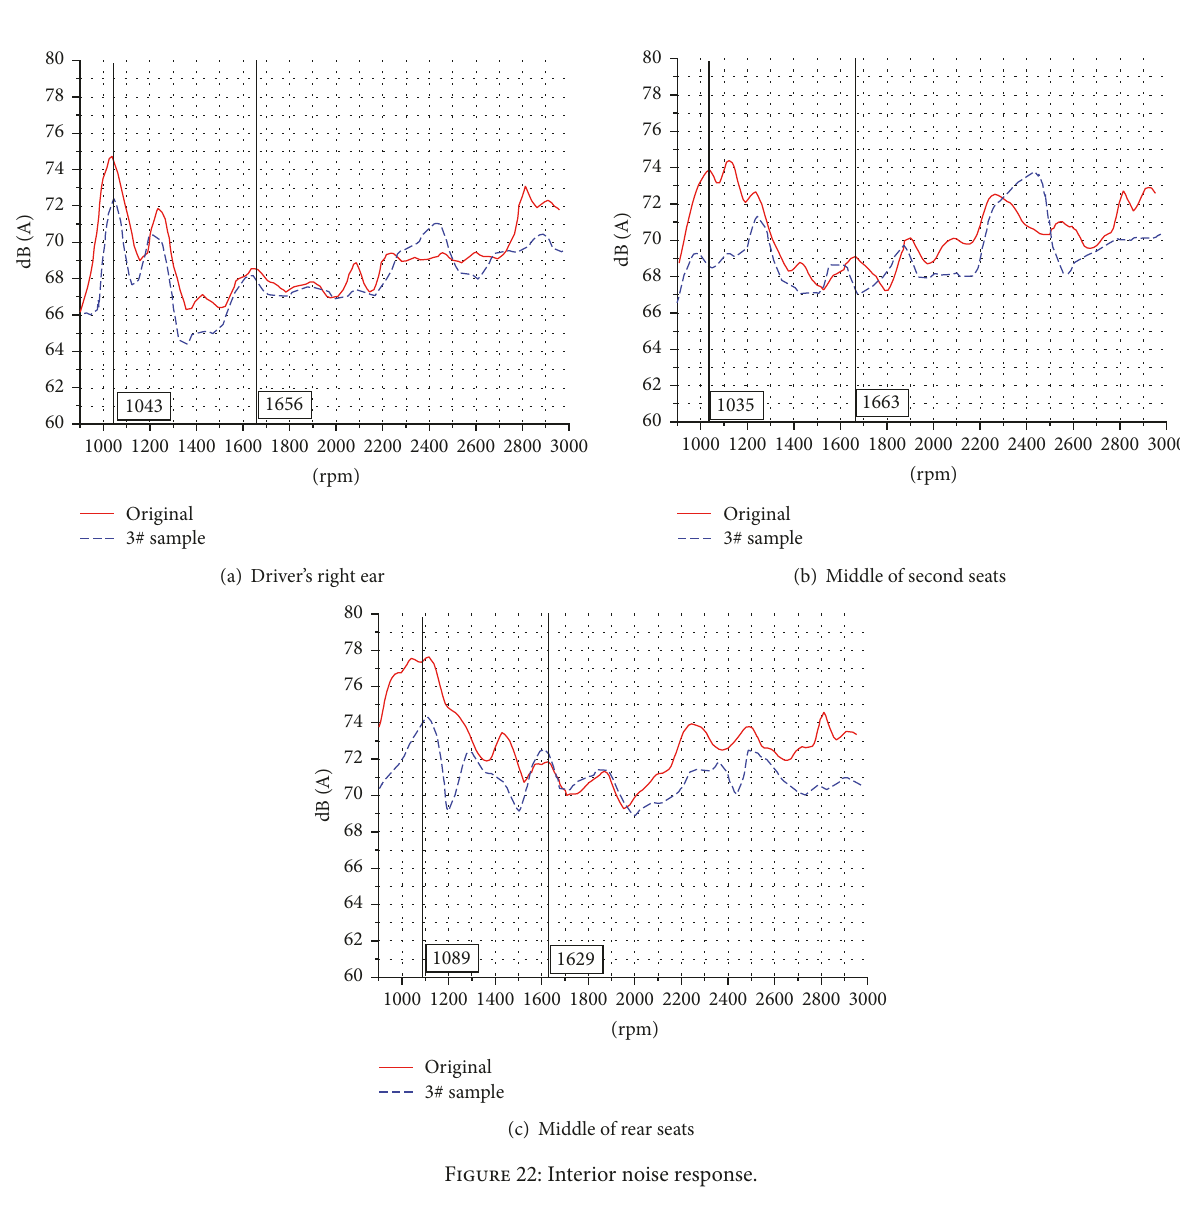
Figure 22: Interior noise